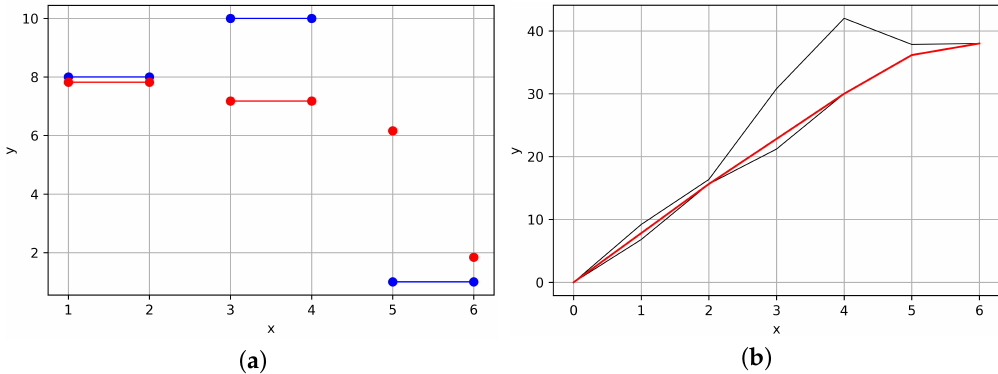
Figure 14. ( a ) Original discrete function u 0 (blue) and its intervals of constancy, extremal function u ∗ (red) and its intervals of constancy; ( b ) the corresponding vertically nonuniform tube (black) and extremal curve L